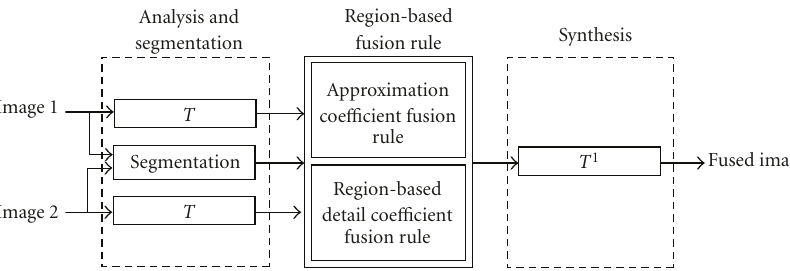
Figure 6: A generalized region-based multiresolution image fusion algorithm.